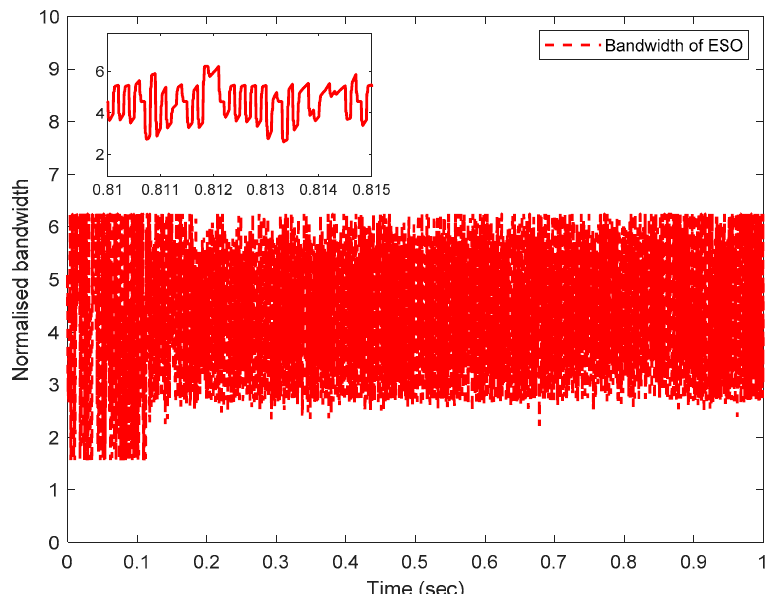
 . Figure 6. Time histories of the observer’s bandwidth control (cid:118) 0 0